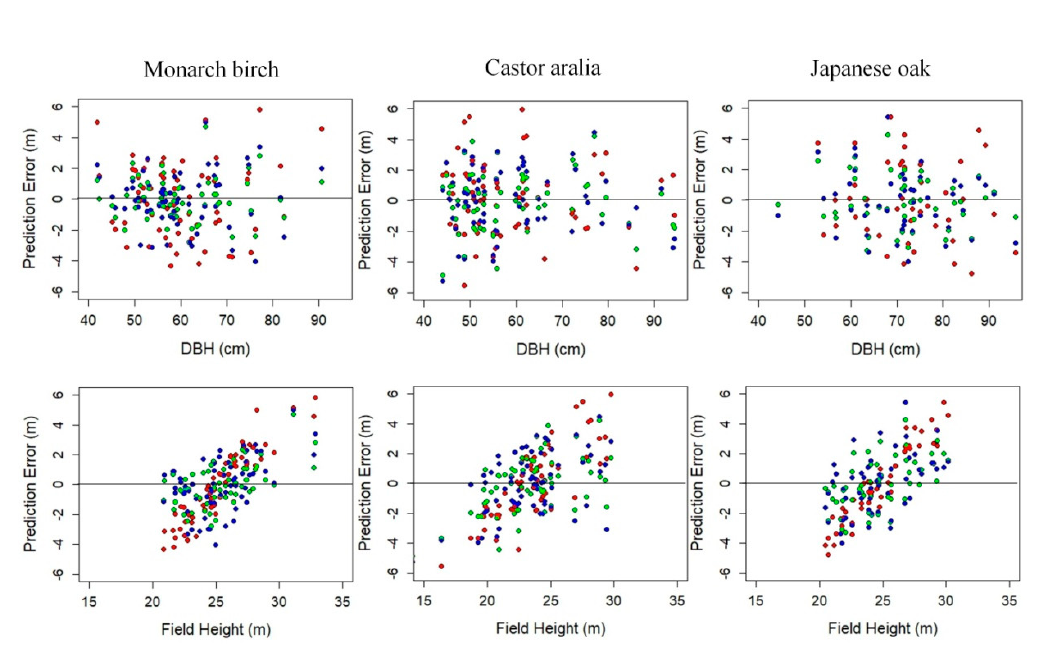
Figure 6. Distribution of prediction error across DBH and height. Red, green, and blue dots represent prediction errors for field height, LiDAR height, and UAV-DAP height, respectively.